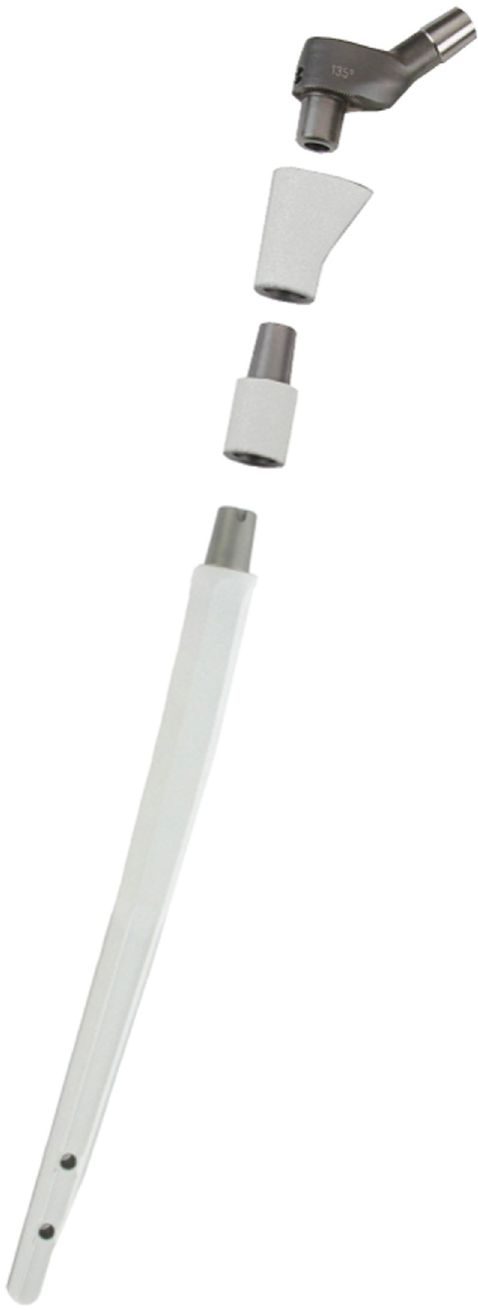
Fig 1. The modular tumor and revision system RS stem. This modular, hexagonal revision system has a hydroxyapatite (HA) coating on the metaphyseal and diaphyseal parts which allows a combined distal and proximal cementless fixation. Additionally, a non HA-coated version for a cemented fixation is